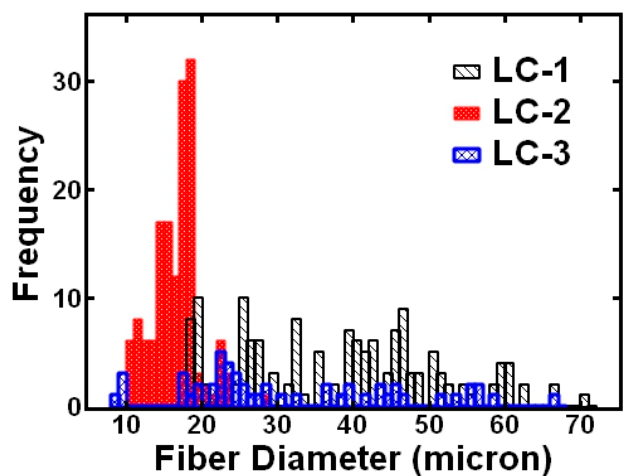
Figure 3. Fiber size distributions for 20 wt.% PS, 20 wt.% LC for the three LC formulations. Table 2. Average fiber sizes for 20 wt.% PS, 20 wt.% LC for the three LC formulations.